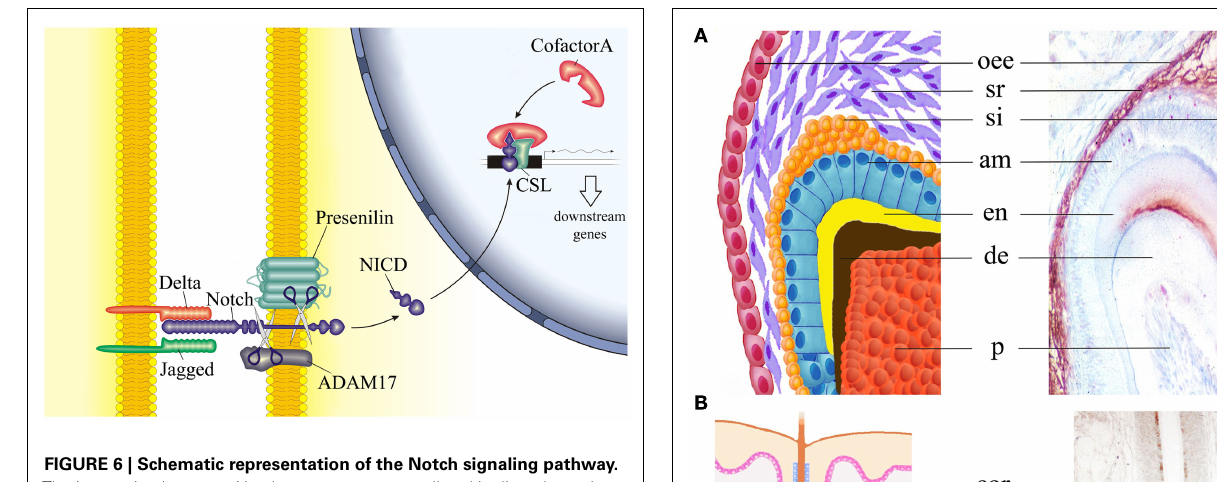
FIGURE 6 | Schematic representation of the Notch signaling pathway. The interaction between Notch receptor on one cell and its ligands on the neighboring cell results in the proteolytic cleavage of Notch receptor and release of its inter-cellular domain (NICD) into the cytoplasm. NICD therefore translocates to the nucleus and interacts with cofactors to regulate the expression of downstream genes.